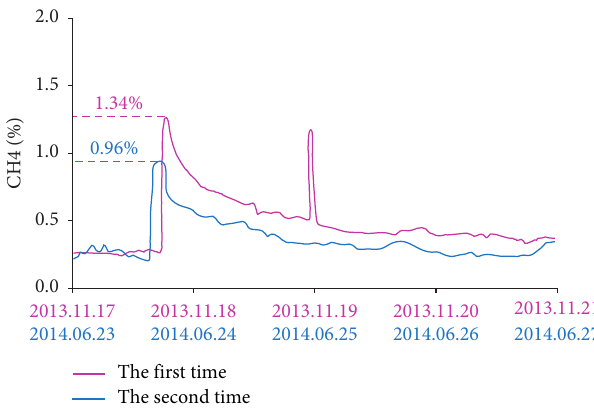
Figure 6: Change curve of gas concentration around sump before and after two floor heave.